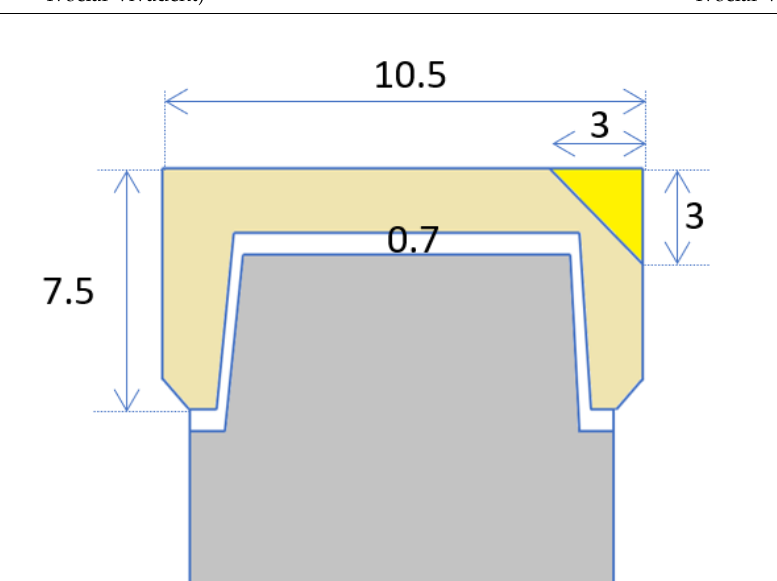
Figure 1. Cross sectional view of specimens used with labeled composition. Cutting plane containing the plane of symmetry of the repaired part and the cylinder axis.